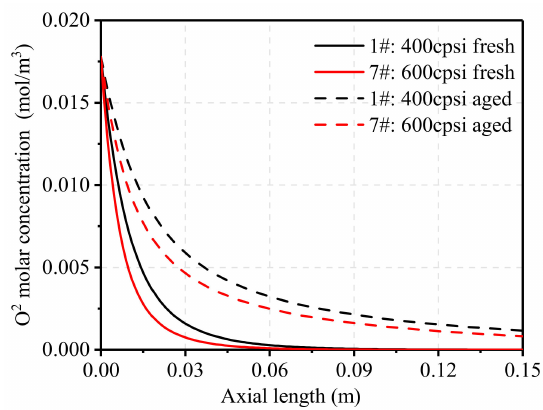
Figure 15. E ff ect of pore density on oxidation reaction rate.